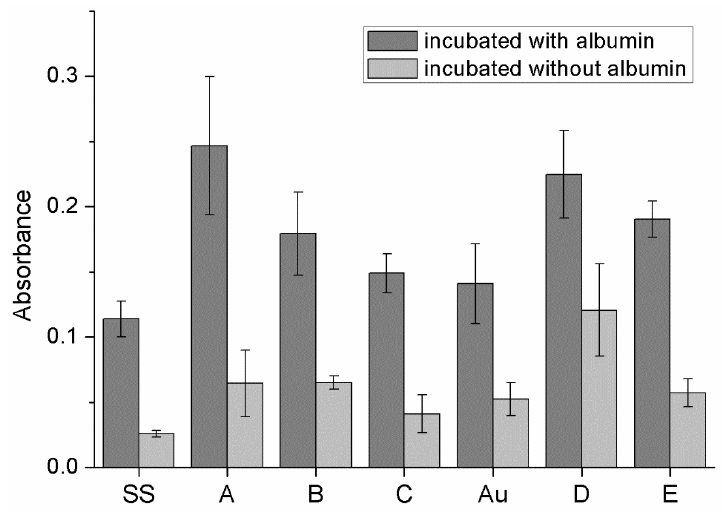
Figure 5. Protein adhesion test results.